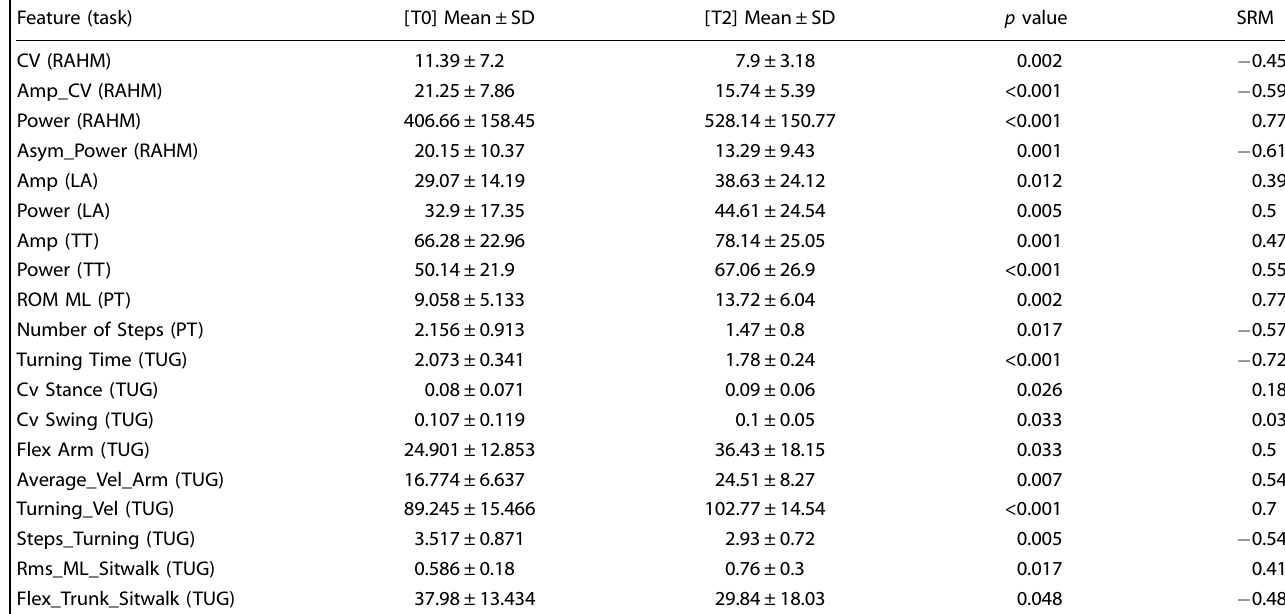
Table 2. Mean values and standard deviations of signi fi cantly improved RAHM, LA, TT, PT, and TUG features in PD patients from T0 to T2.